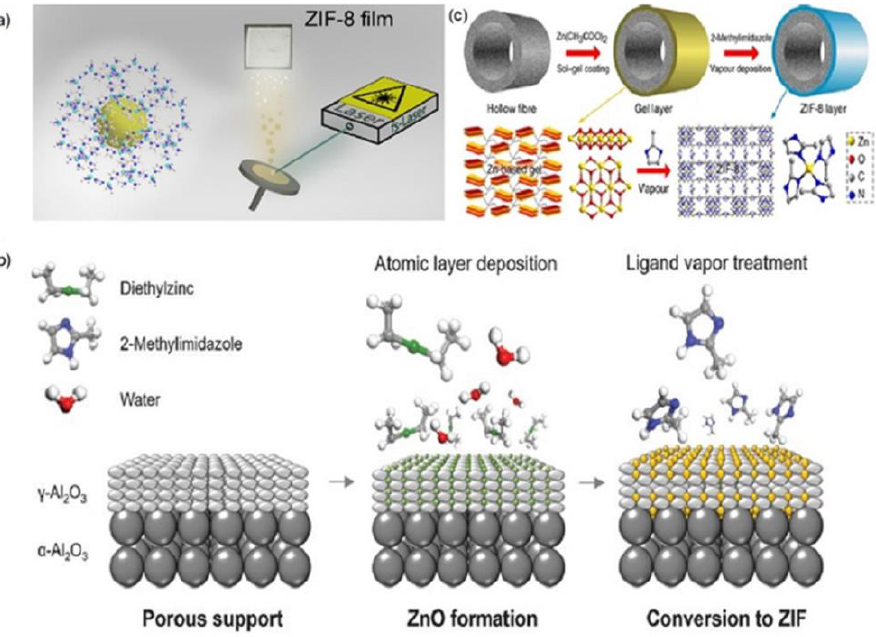
Figure 5. Schematic of MOF membrane formation processes using vapor: ( a ) ZIF-8 membrane deposition via PVD, ( b ) ZIF-8 membrane deposition via CVD and ( c ) ZIF-8 membrane deposition via GVD. Reprinted with permissions from Refs. [94,97,101].